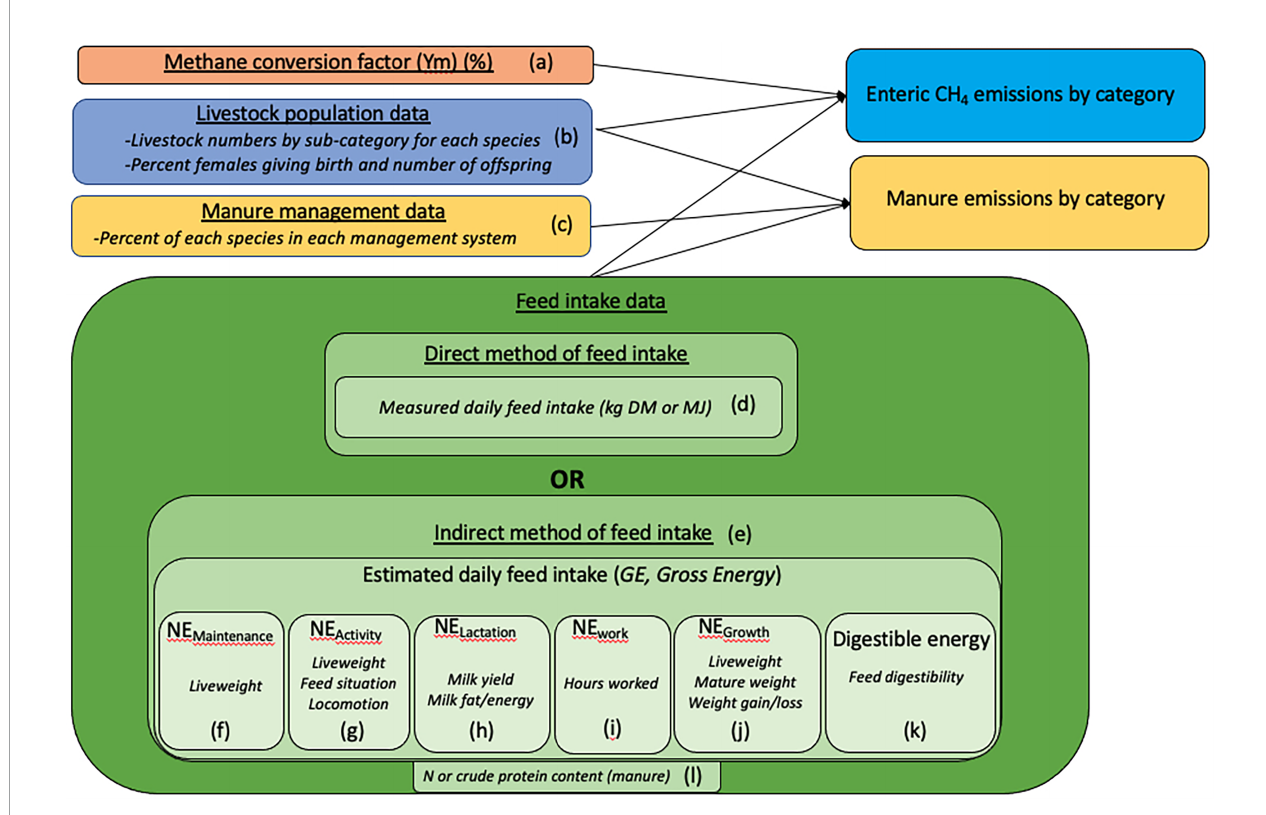
FIGURE 1 | Flow diagram showing activity data and model input requirements for indirect estimation of Tier 2 emission factors for livestock based on IPCC guidelines. Lower part of the diagram shows additional data requirements for “ feed intake data ” using direct and indirect estimation for estimating feed intake. NE , net energy requirements; GE , gross energy